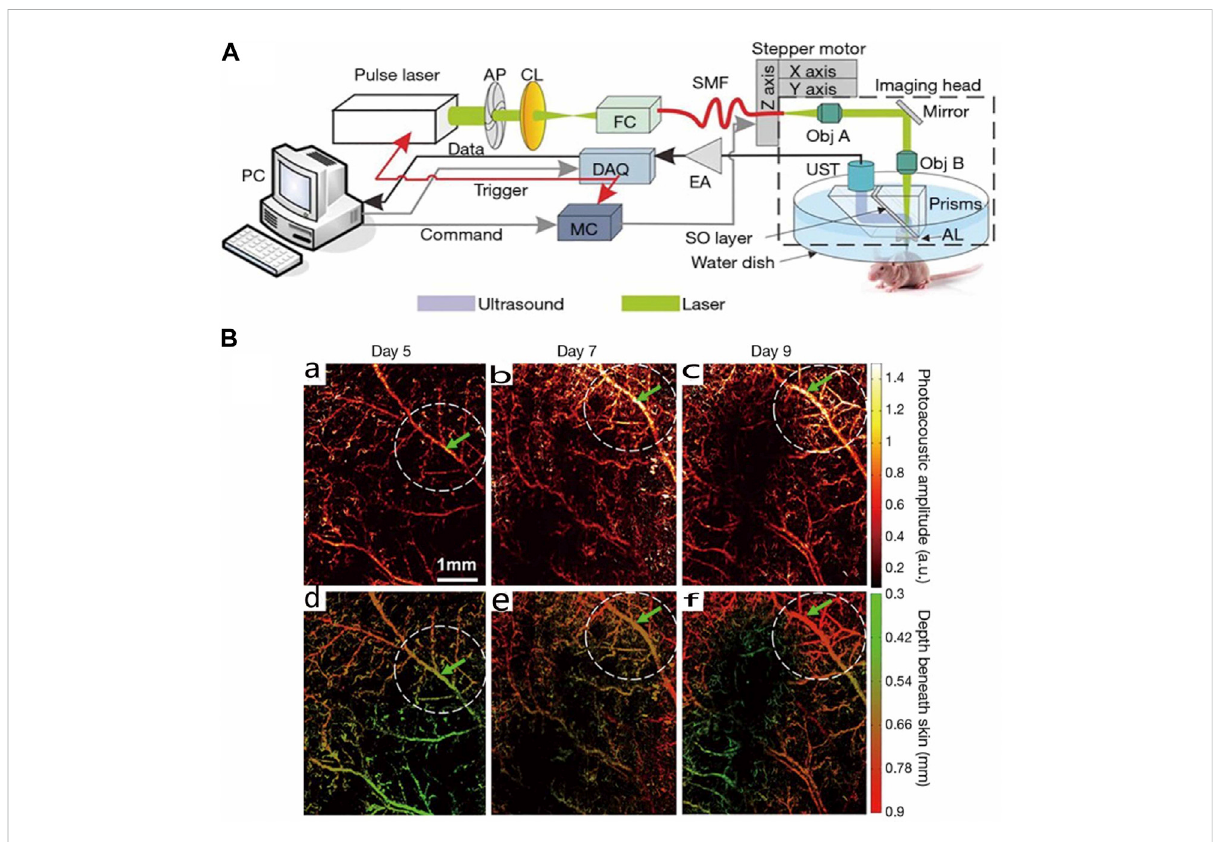
FIGURE 3 (A) Schematic of the optical-resolution photoacoustic microscopy (OR-PAM) system. (B) Maximum amplitude projection OR-PAM images of developing 4T1 tumor angiogenesis on (a) day 5, (b) day 7, and (c) day 9 post implantation. (d – f) Depth-encoded maximum amplitude projection corresponding to (a – c). The super fi cial and deep vessels are depicted in green and red, respectively